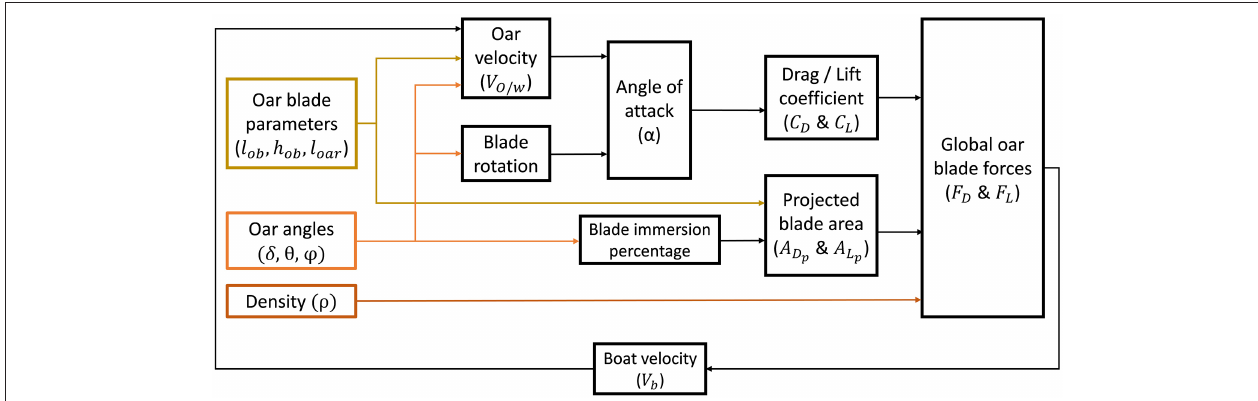
FIGURE 2 | Flow chart of the angle-dependent water interaction model. Oar angles ( δ , θ , ϕ ) were received from sensors. Oar blade parameters were adapted from von Zitzewitz et al. (2008) and the value of density (range 50–4000 kg